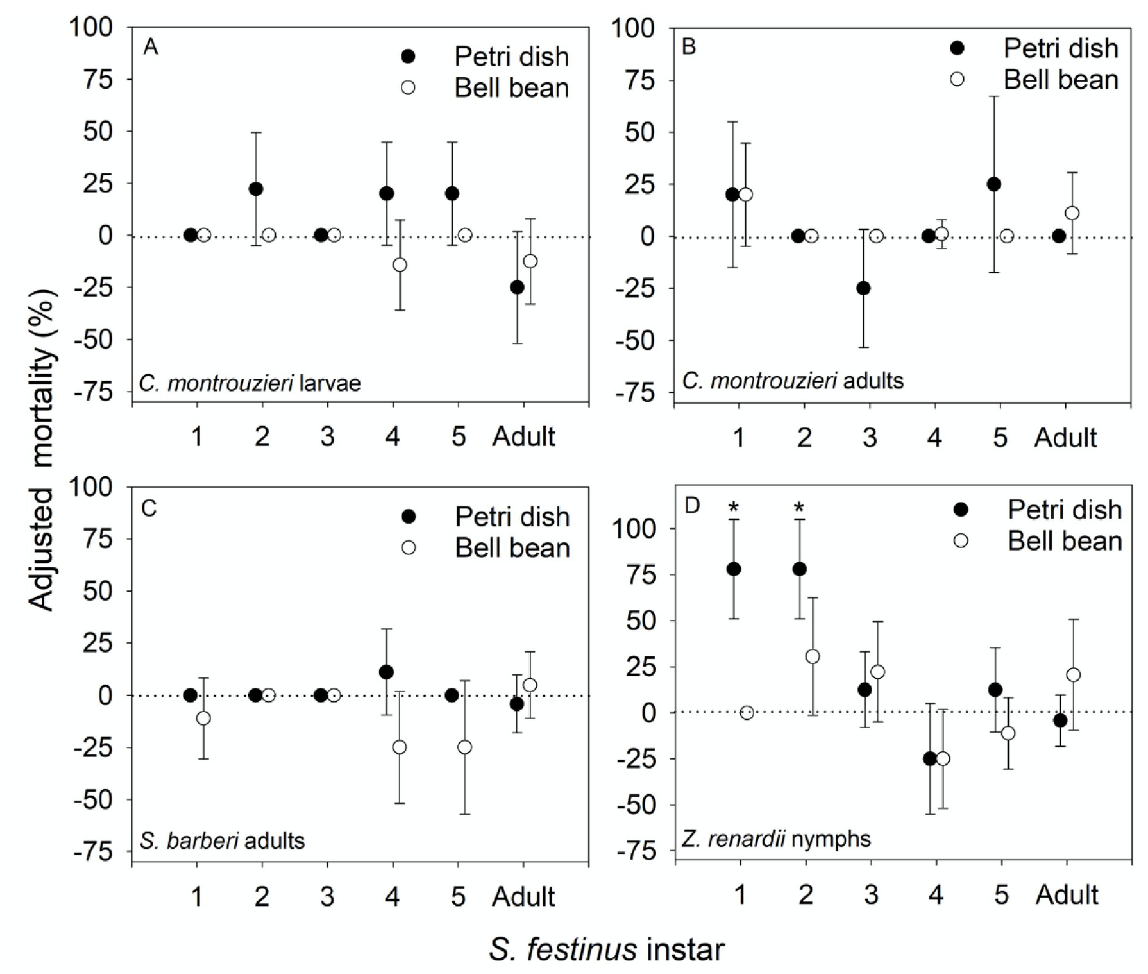
Fig 1. Results of petri dish and bell bean bioassays using A) C . montrouzieri larvae, B) C . montrouzieri adults, C) S . barberi adults, and D) Z . renardii nymphs. The percentage of prey that were killed in predator treatments was adjusted using Abott’s formula to account for background mortality observed in controls. Error bars represent 95% confidence intervals. Mortality was considered significant if it was positive and the confidence interval did not overlap with zero (indicated by an asterisk). Negative adjusted mortality values indicate greater mortality in controls than in predator